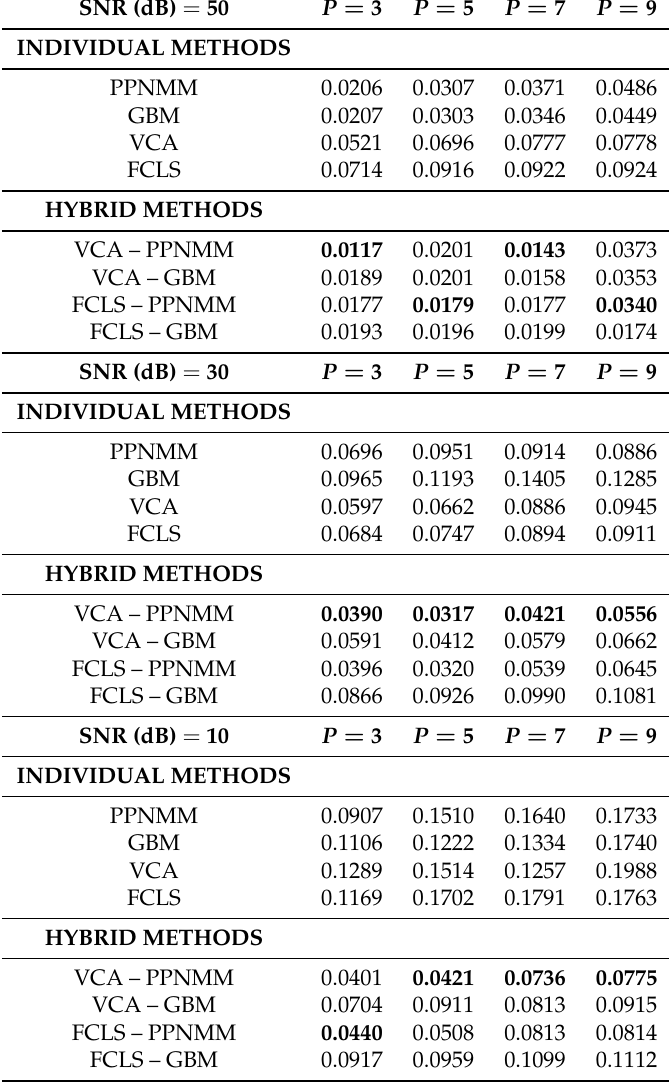
Table 1. Abundance estimation error (3 × 3 window )of the individual and hybrid methods between linear and nonlinear spectral unmixing with different signal to noise ratios and endmembers. The best results are shown in